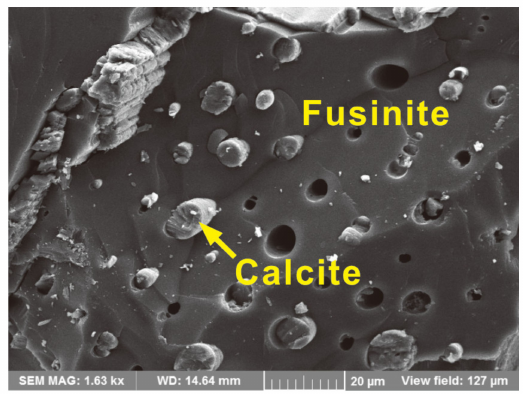
Figure 9. Calcite filling in the pores of fusinite, SEM